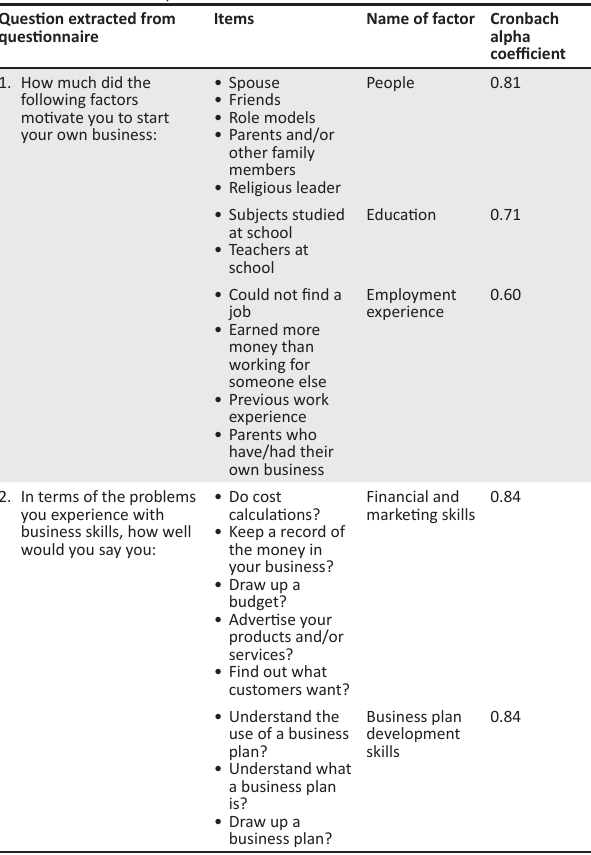
TABLE 2: Factors and questionnaire items. Question extracted from questionnaire